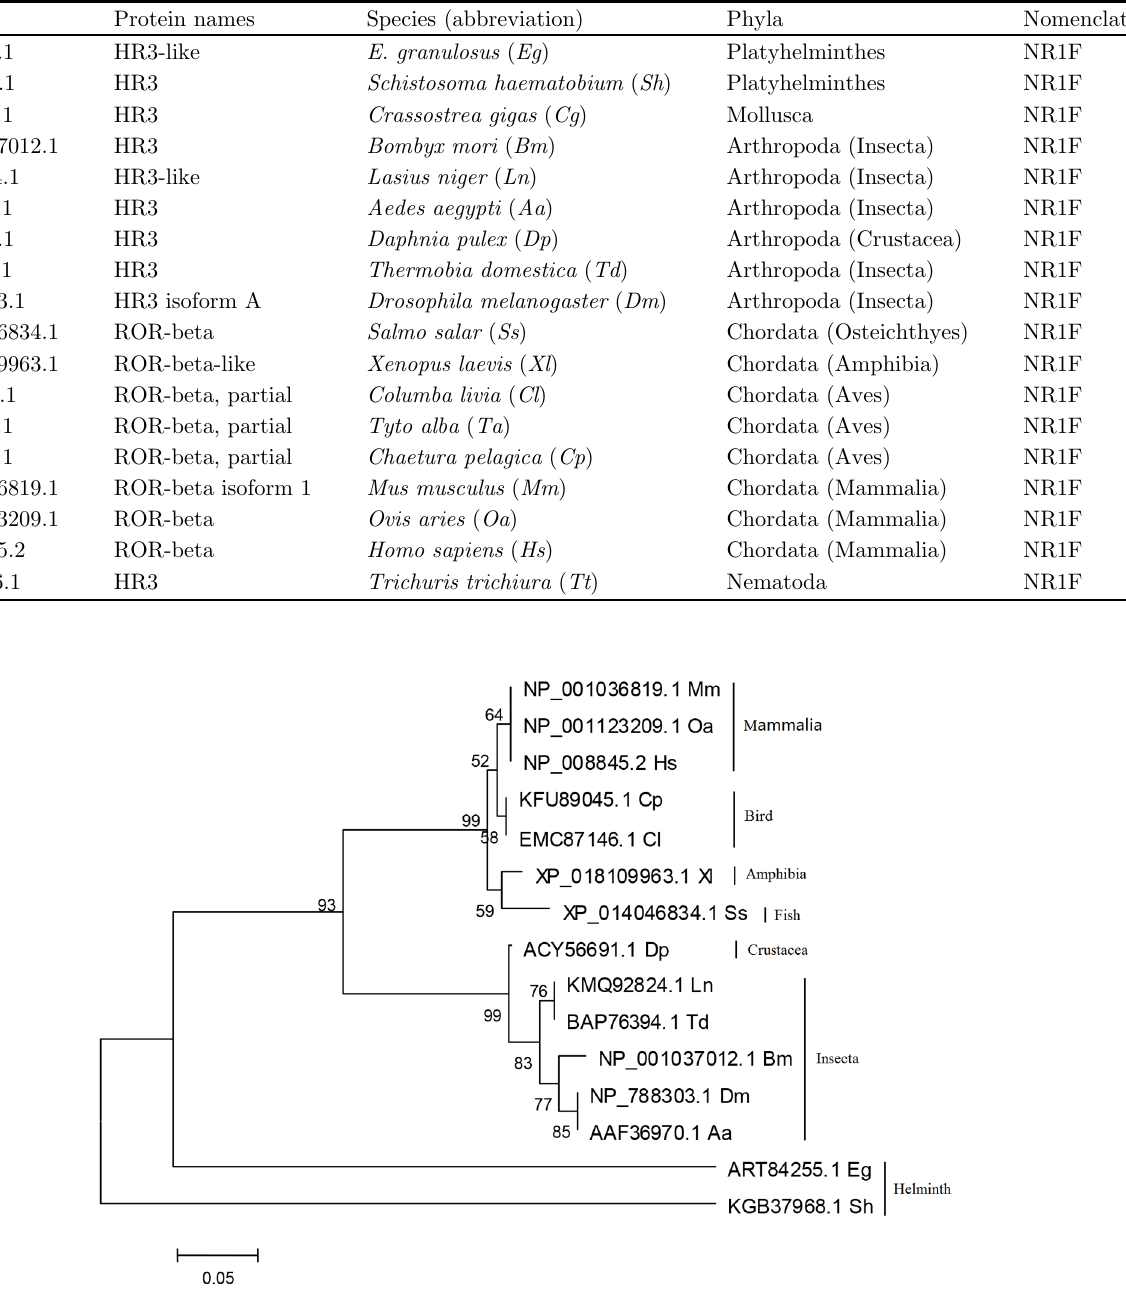
Figure 3. Phylogenetic analysis of the DBD sequence of E. granulosus EgHR3-like protein (ART84255.1) with DBD sequences of HR3/ROR from other species. Sequences used for phylogenetic analysis are shown in Table 1.